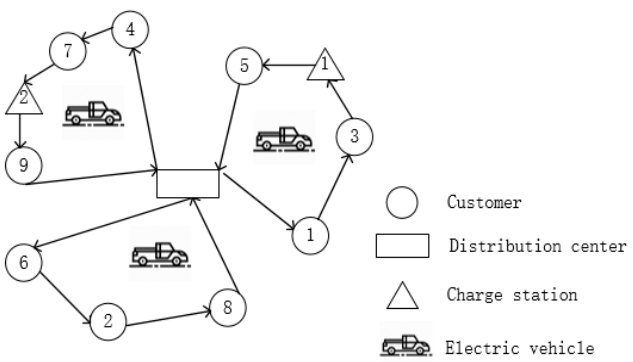
Figure 1. A simplified diagram of electric vehicle routing problem (EVRP).